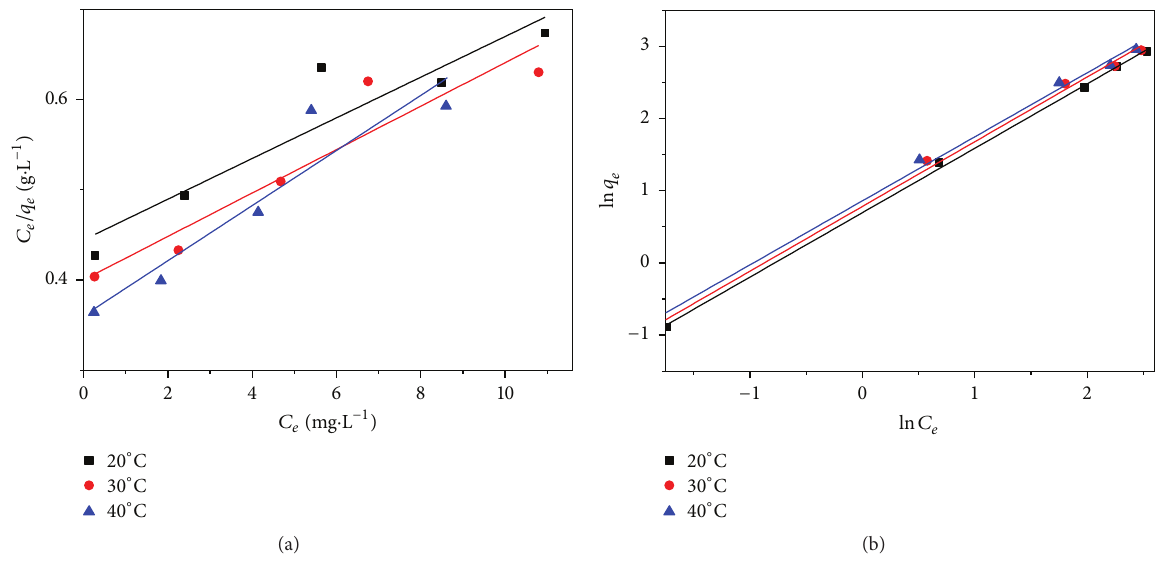
Figure 6: The linearized adsorption isotherm of As (III) on Ce-Al-Fe trimetal oxide adsorbent ((a) Langmuir isotherm model and (b) Freundlich isotherm